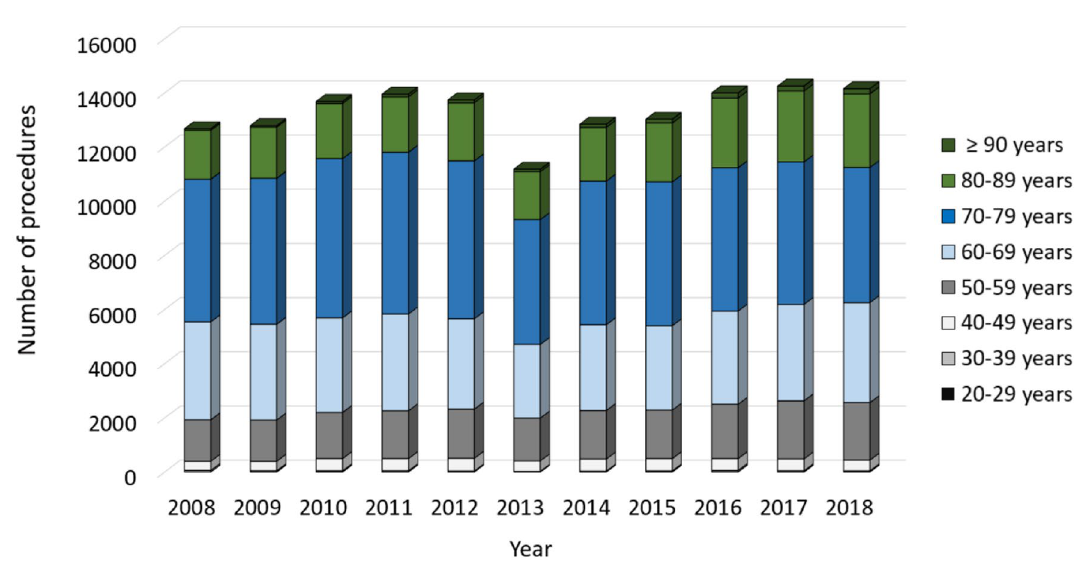
Figure 3. Revision knee arthroplasty procedures of female patients from 2008 through 2018 divided by